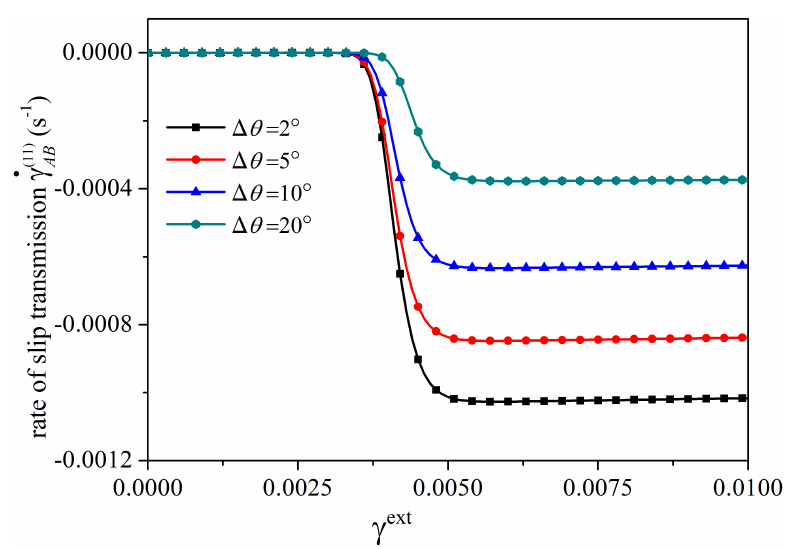
Figure 6. Influence of grain misorientation on the rate of slip transmission. For a smaller grain misorientation angle, the steady-state value of slip transmission is larger, implying that the occurrence of slip transmission is